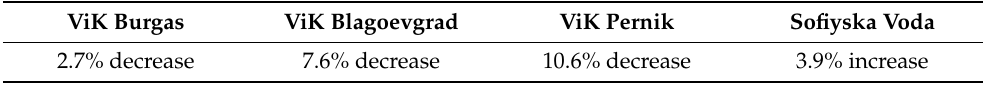
Table 4. Trends in population in the investigated WSSOs for the period